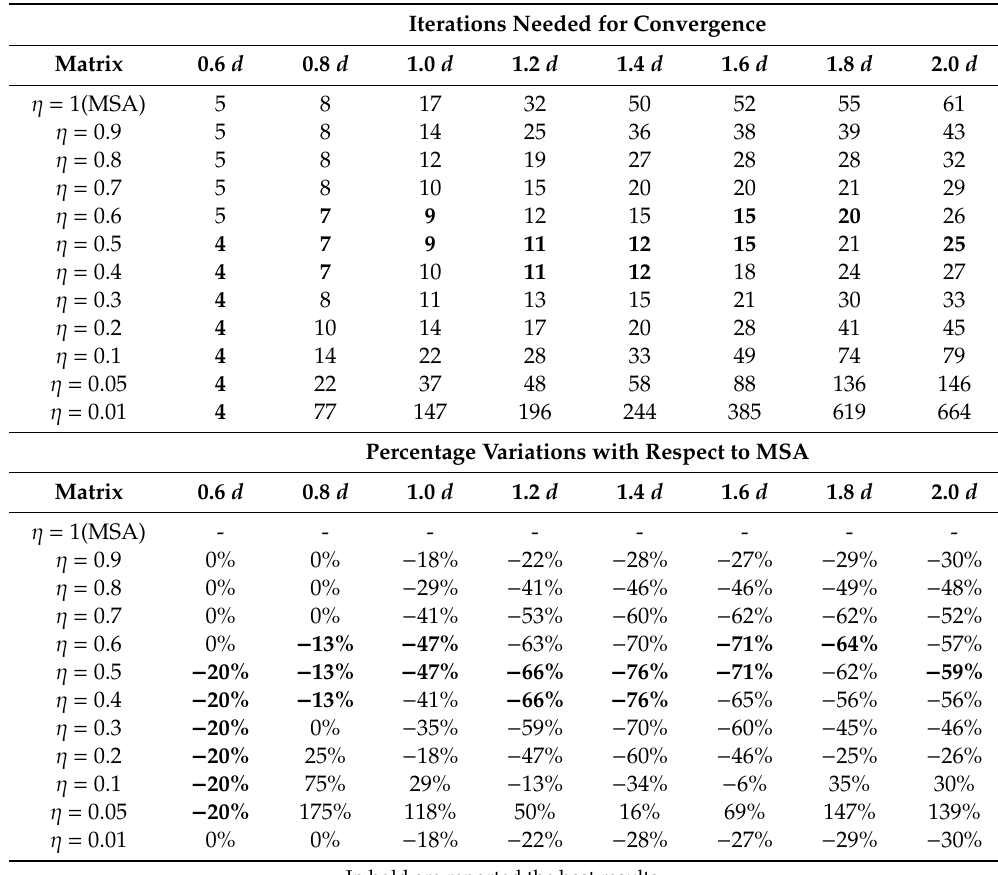
Table 6. Results on the urban real-scale network ( C v =